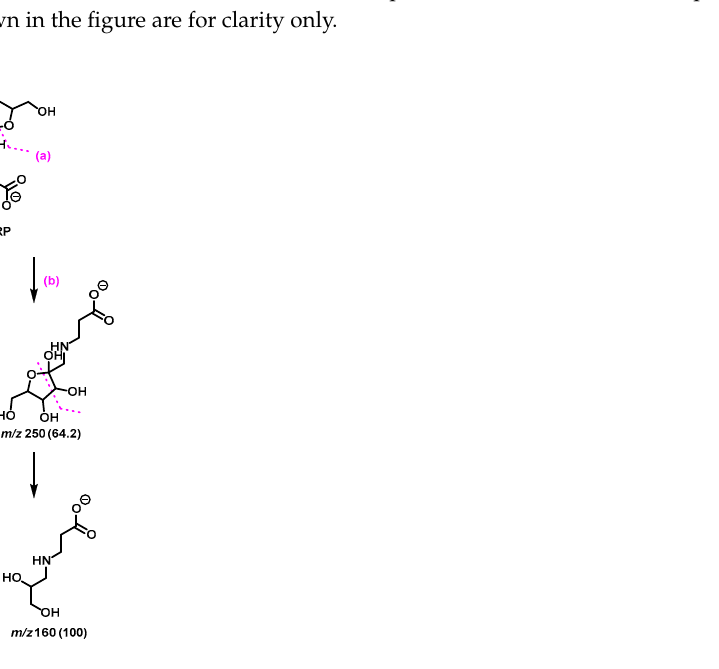
Figure 5. Proposed MS/MS fragmentation pathway of N,N -difructosyl- β -alanine (ARP-ARP) under negative ionization mode. Diagnostic ion for ARP-ARP is indicated in the square box. Relative abundances are shown inside the brackets.